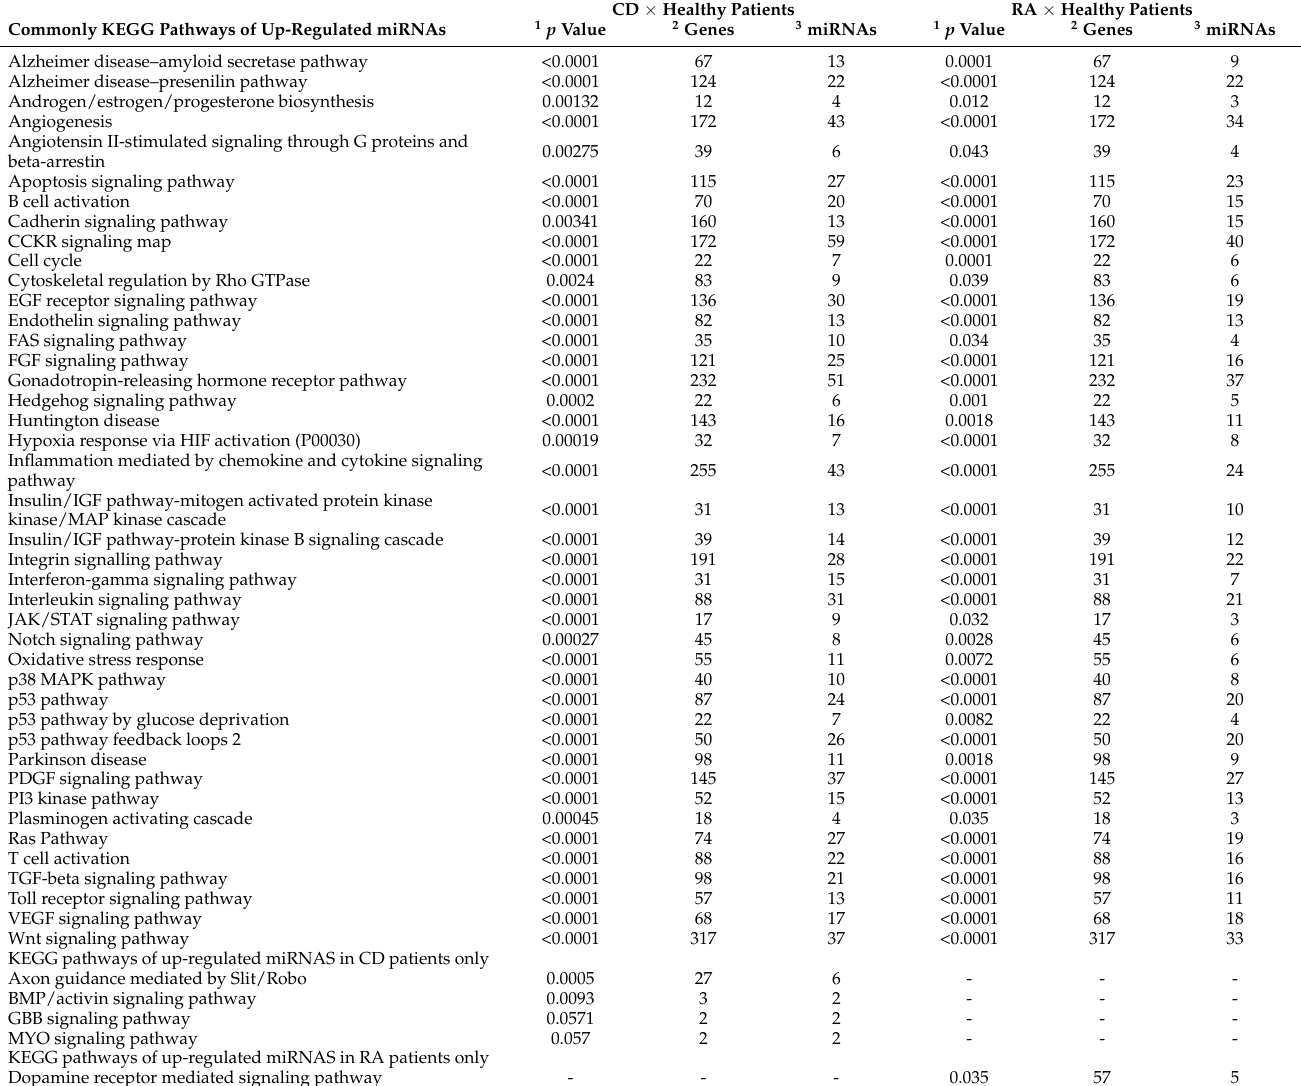
Table 2. Enriched pathways from target genes of up regulated miRNAs from CD and RA compared to health